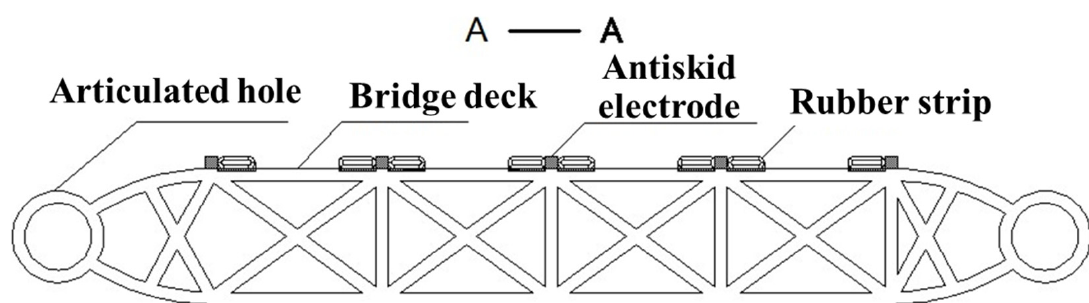
Figure 5. The unit of the upper surface of the bridge deck.